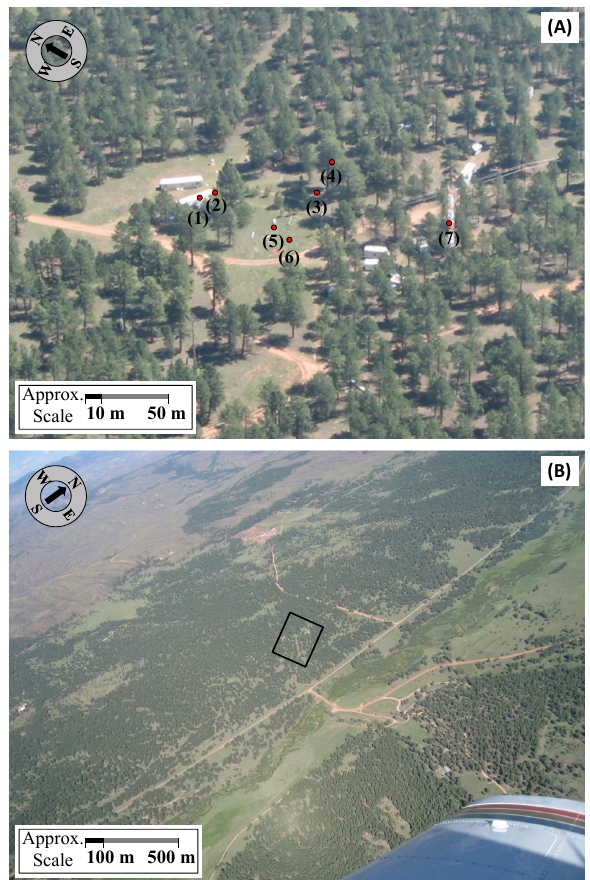
Fig. 1. Aerial photos of site layout. (A) Approximate lay-out of sampler and instruments: (1) Inlet #4 [CFDC], (2) Inlets 1–3 [#1: UV-APS, #2: MOUDI, #3: Total aerosol impactor + stacked fil- ter unit], (3) Andersen biosamplers, (4) High-volume samplers, (5) Leaf wetness sensor (LWS), (6) Disdrometer, (7) WIBS profiling unit on Chemistry Tower. Instruments and samplers associated with inlets 1–4 are located inside trailer (white box). Additional de- tails regarding other instrumentation and lay-out at: http://web3.acd. ucar.edu/beachon/site-info.shtml. (B) Aerial photo showing region immediately surrounding Manitou Experimental Forest sampling site, including county road 67 crossing north through the photo. Black box shows approximate area of photo (A) . Photos courtesy: J.